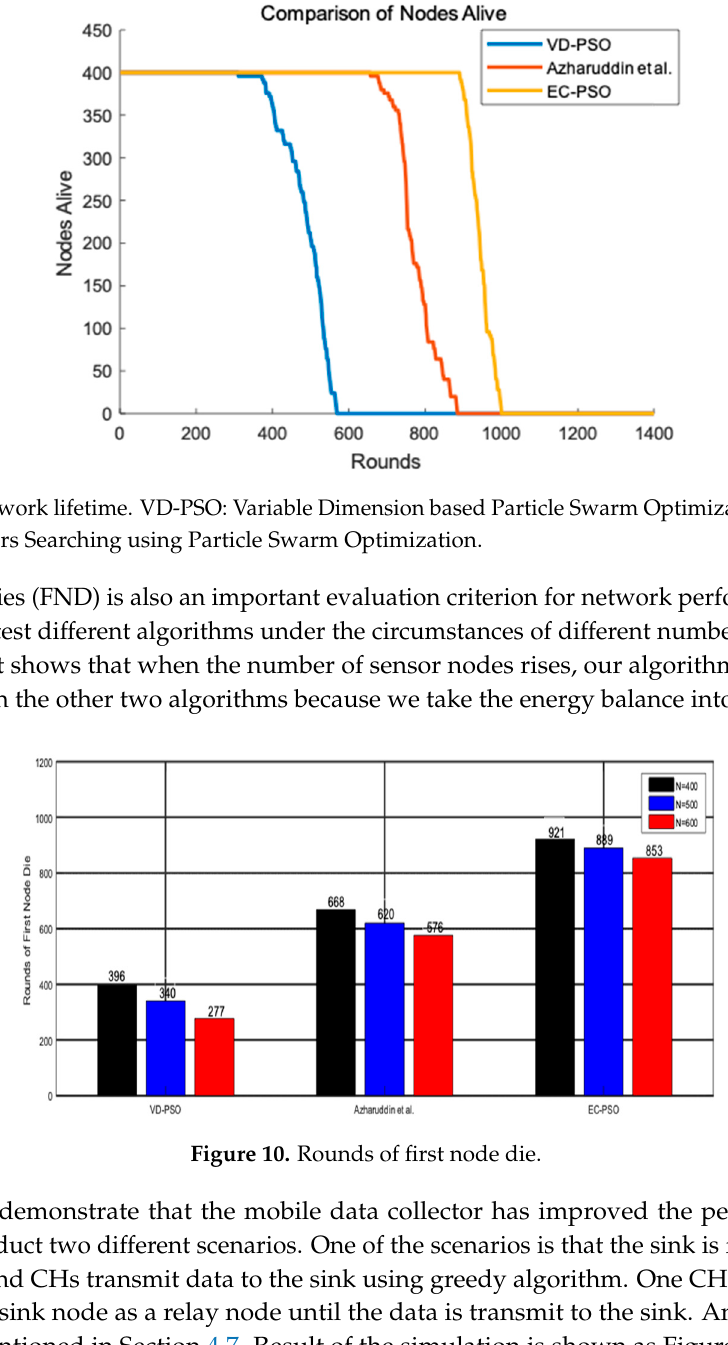
Figure 8. Energy consumption of the network.